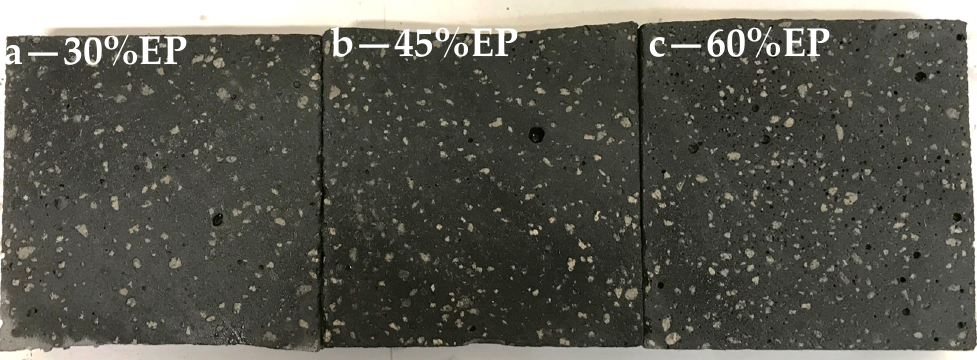
Figure 5. Distribution of EP in the structure of lightweight RPC 30% EP ( a ), 45% EP ( b ), and 60% EP ( c